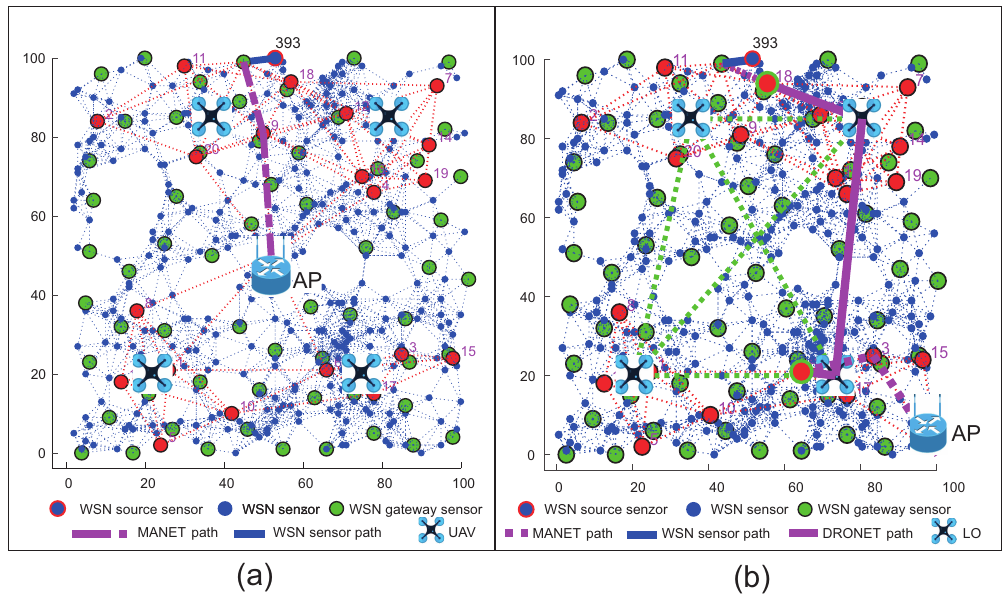
Figure 21. The example of optimal routing path in WSN-MANET-DRONET network. ( a ) Expample of optimal routing path through WSN and MANET layer. ( b ) Example of optimal routing path through WSN, MANET and DRONET layer.